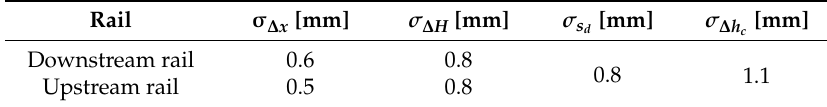
Table 2. Average precision of the coordinates, i.e., the precision of the deviations, spans, and height differences of the rails.